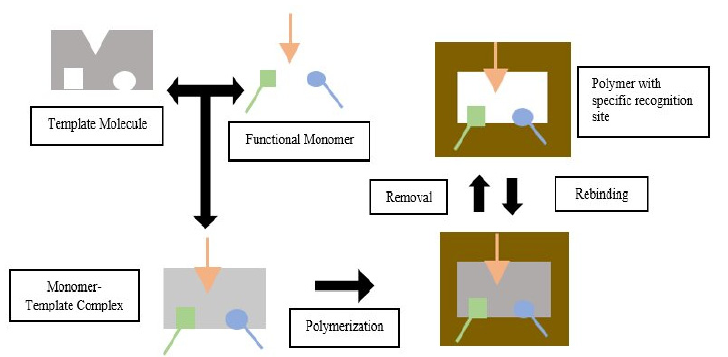
Figure 1. Molecular Imprinting Process (green, orange and blue arrow indicated different type of functional groups that could be appeared in the functional monomer).